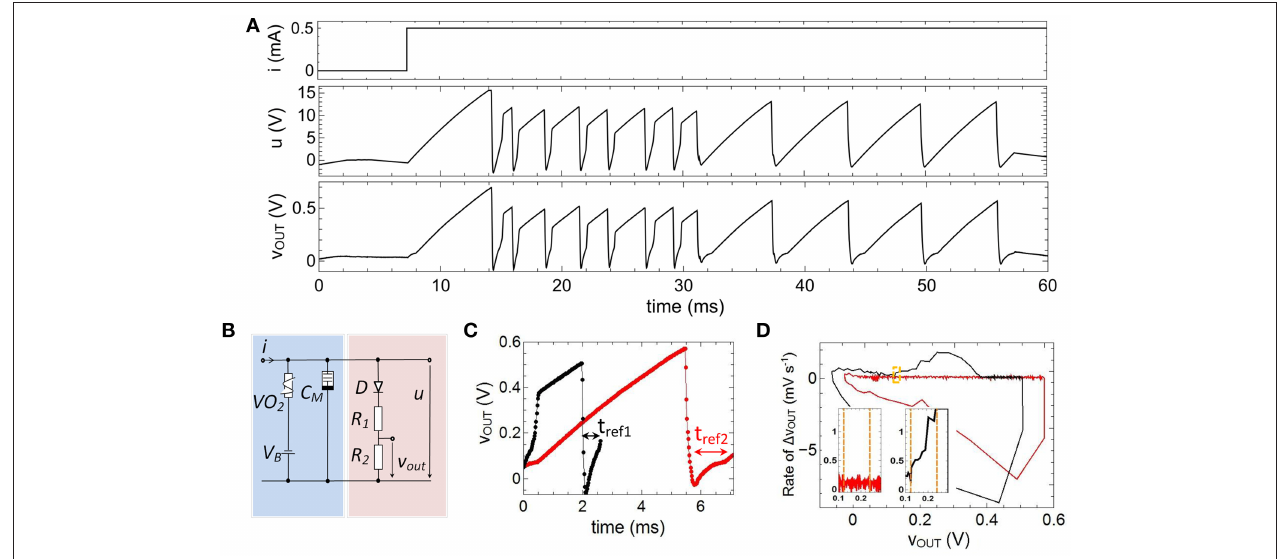
FIGURE 7 | Emulation of adaptation: (A) Measured spike pattern for a constant current input based on a memcapacitance C M (t) . (B) Layout of the investigated circuit which corresponds to the one depicted in Figure 2 . (C) Characteristics of two individual spikes and corresponding phase diagram (D) , where the insets show the initial phase of the spikes. Parameters used for the circuit: R 1 = 1 M (cid:127) , R 2 = 47 k (cid:127) , C 1 = 0.165 µ F, C 2 = 0.068 µ F, V B = −